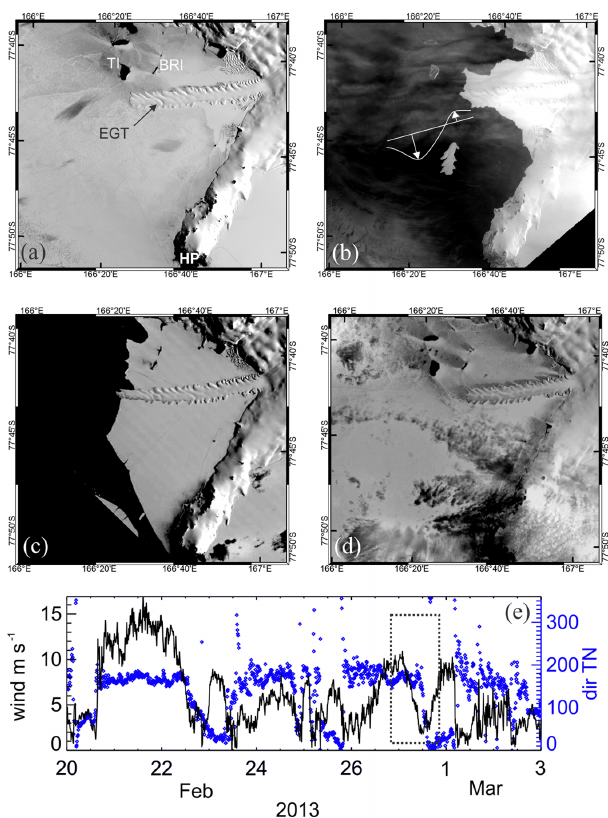
Fig. 1. ASTER images from (a) year day 12 (12 January 2013), (b) year day 58 (27 February 2013) showing tip moving south and speculated current shear described in the text. Landsat 4TM images from 1989 showing (c) year day 29 (29 January 1989) and (d) year day 349 (14 December 1992). The Erebus Glacier Tongue (EGT), Tent Island (TI), Big Razorback Island (BRI) and Hut Peninsula (HP) are marked in (a) . (e) Shows the wind velocity (direction is that of wind origin) recorded at Cape Royds, 20km north of the EGT.